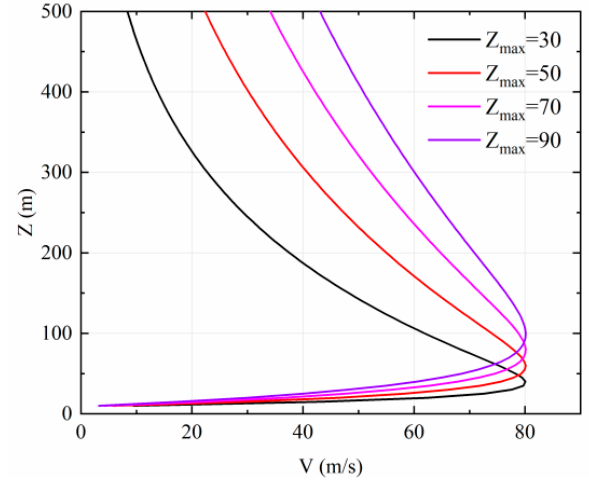
Figure 15. The wind profile of the Vicory model under different Z max ..